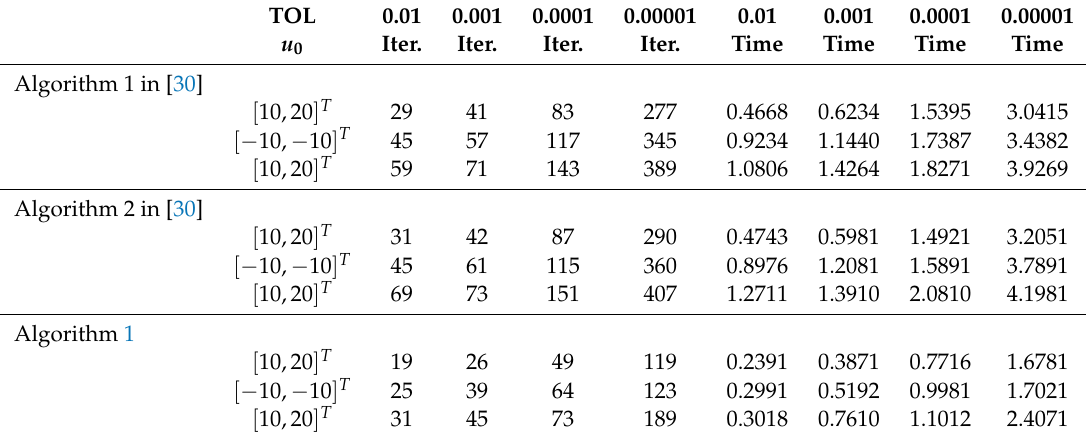
Table 3. Numerical behaviour of Algorithm 1 compared to Algorithm 1 in [30] and Algorithm 2 in [30] for Example 3 by using different initial points u 0